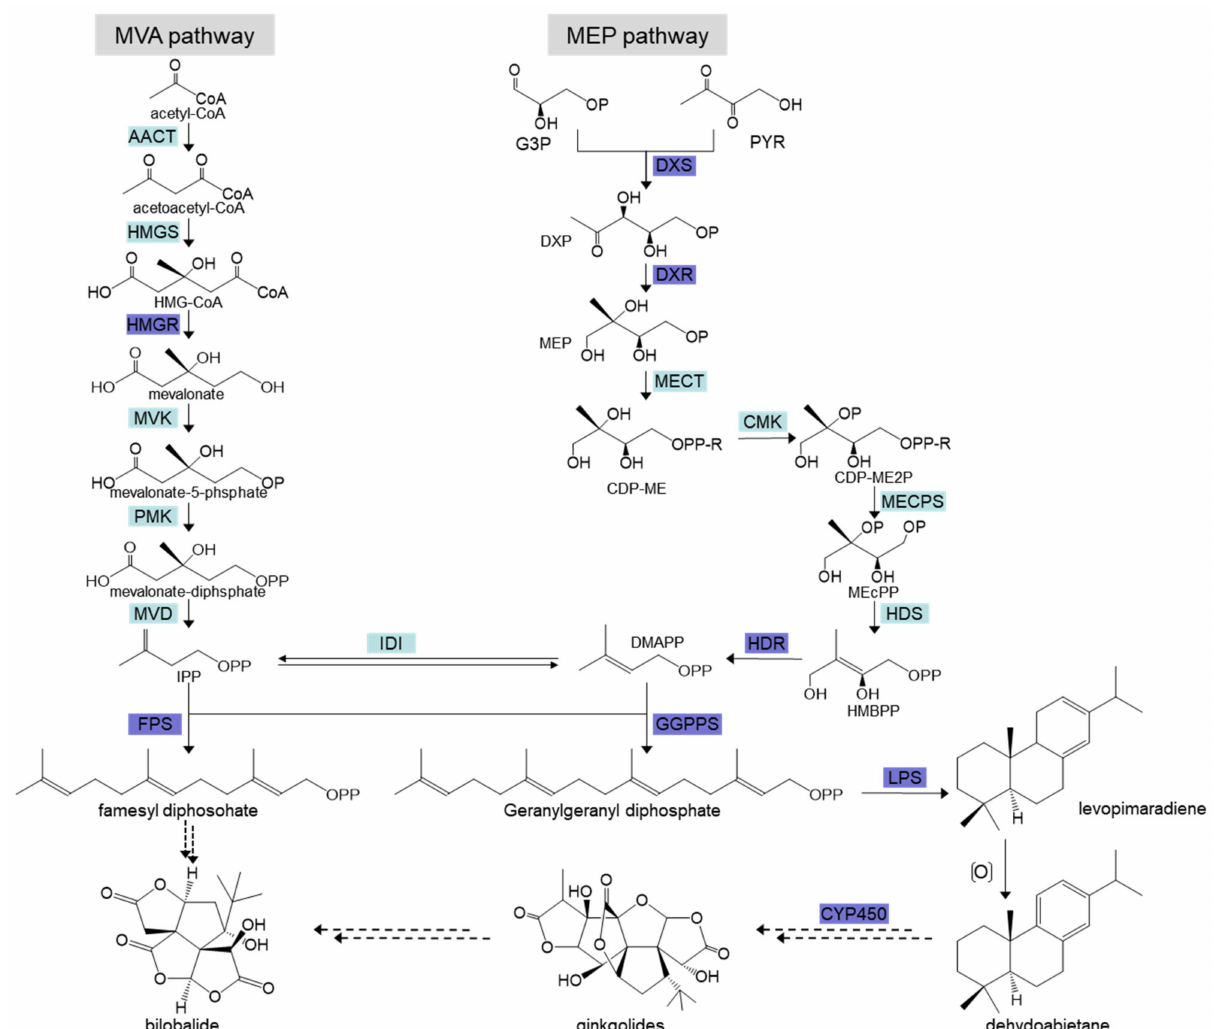
Figure 1. Biosynthetic pathways of ginkgolides and bilobalide in Ginkgo biloba . Inducible factors can stimulate the expression of key genes in the plant biosynthesis pathway, thus regulating the synthesis of secondary metabolites [12]. Depending on